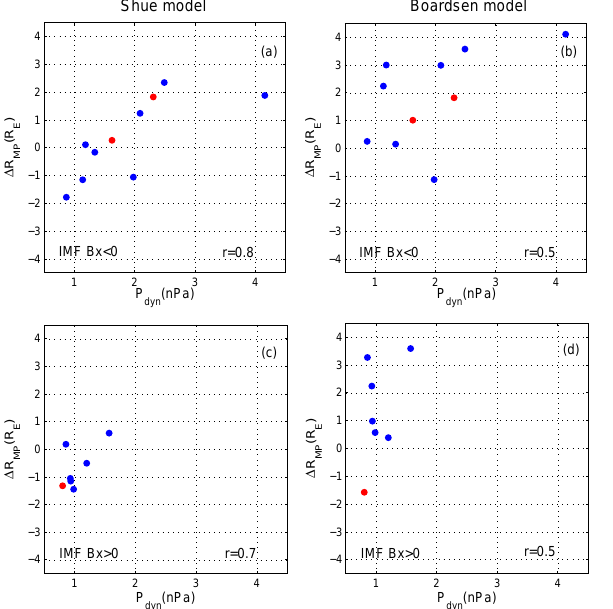
Figure 5. Differences between observed and modeled magne- topause as a function of the dynamic pressure. Panels from top to bottom show earthward and sunward IMF crossing events. Left (right) panels are the results of the Shue98 (Boardsen00) model. The correlation coefficients are given. Red (blue) dots indicate the northern (southern) midlatitudinal crossings.